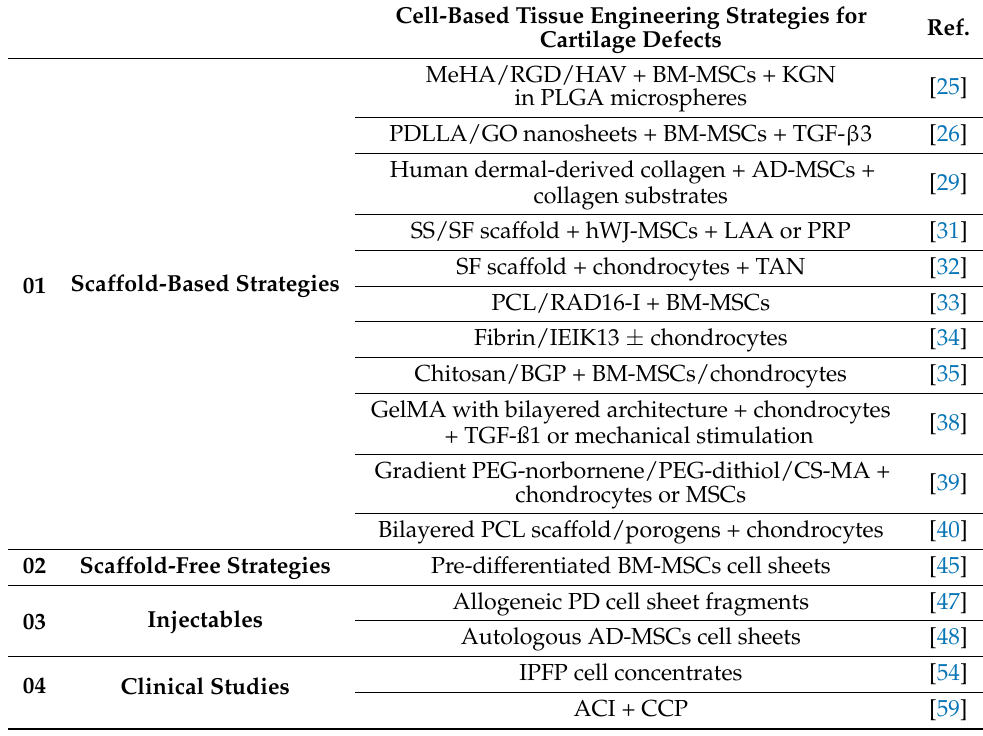
Table 1. List of studies on cell-based tissue engineering strategies for cartilage defects.